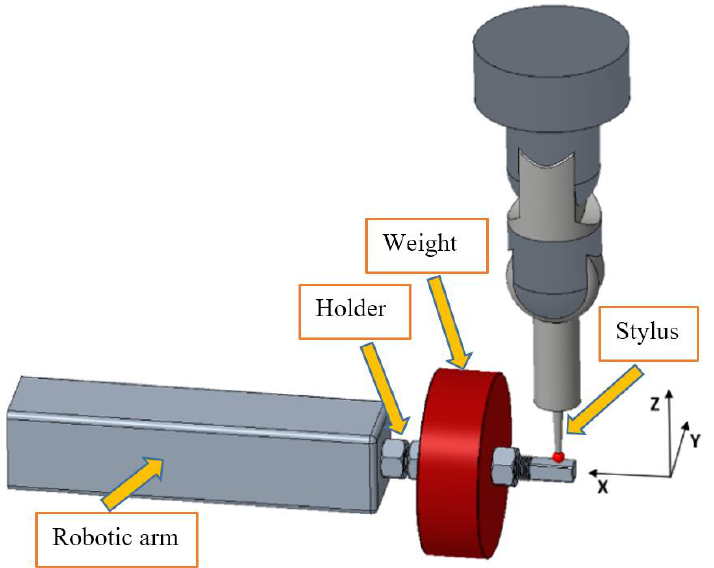
Figure 4. Contact measuring method (CoM) of robotic arm’s position using a 3D measuring machine.